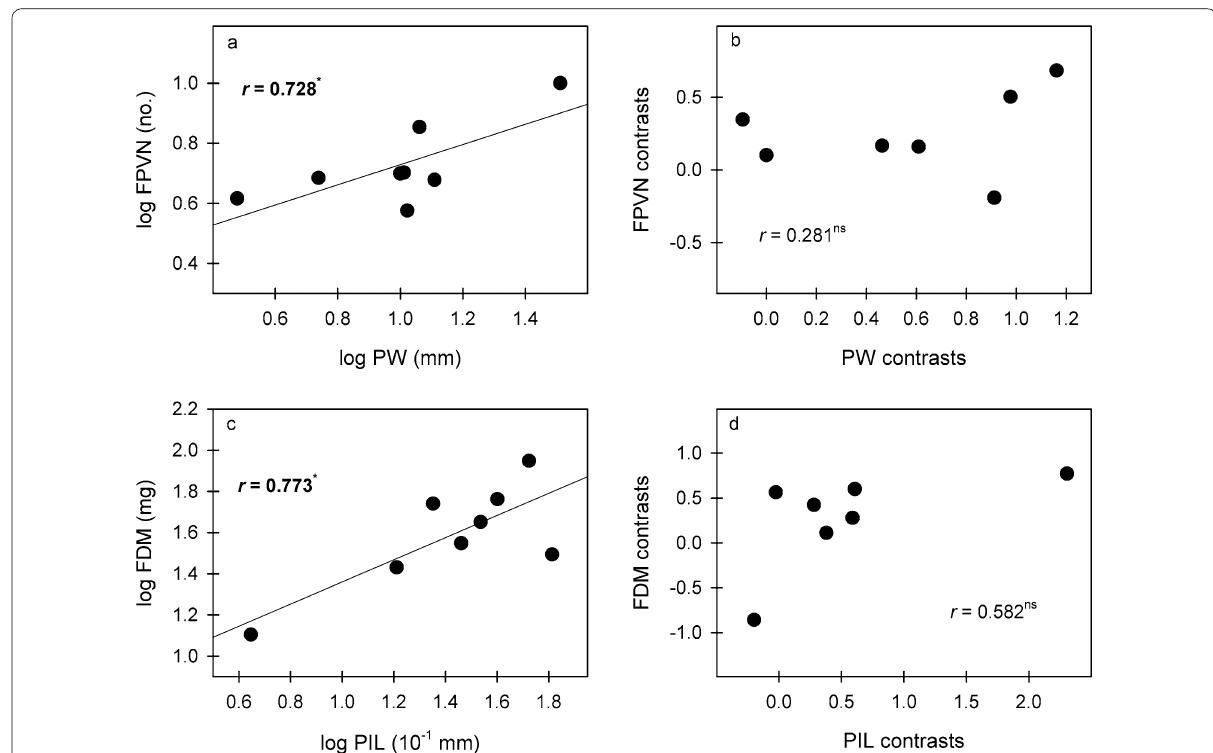
Fig. 5 Significant correlations of species mean values and PICs between pseudobulb traits and flower traits. * p < 0.05; ** p < 0.01. PW pseudobulb width, PIL pseudobulb internode length, FDM flower dry mass, FPVN flower petal vein